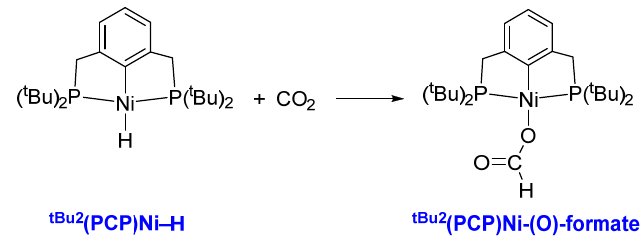
Figure 1. Reaction of CO 2 with tBu2 (PCP)Ni-H.